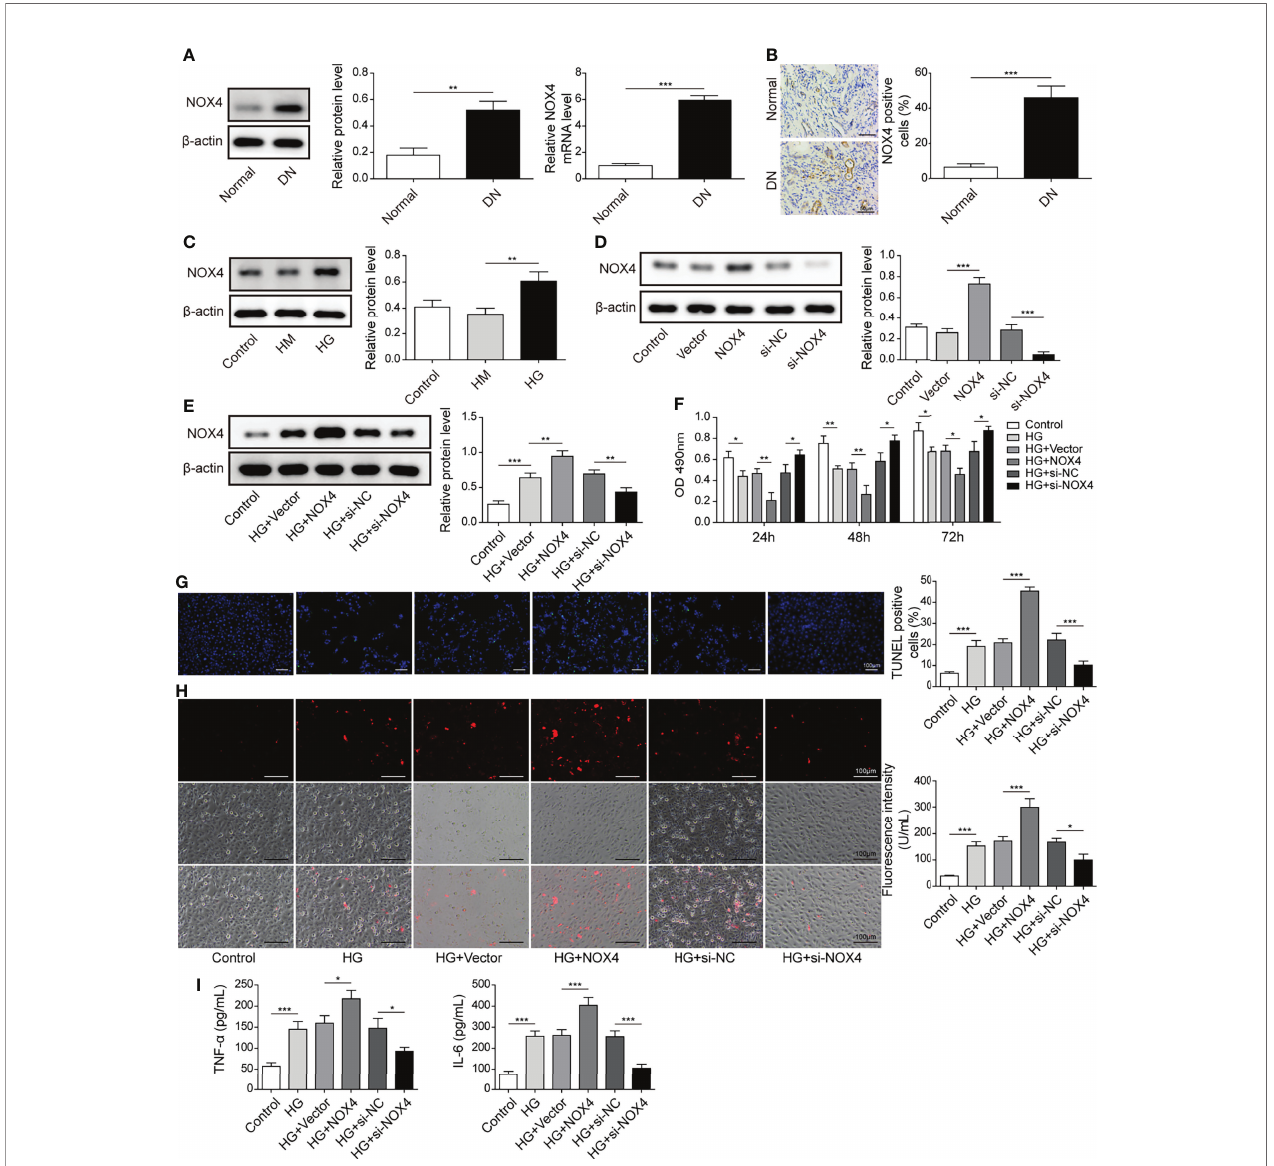
FIGURE 6 | Nox4 exacerbated HG-induced injury in HK-2 cells. (A) The expression of Nox4 in DN and normal tissues was analyzed by qRT-PCR and western blotting (n=6). (B) IHC staining of Nox4 (n=6). (C) Protein levels of Nox4 in HK-2 cells treated with NG, HM or HG were examined by western blotting (n=4). (D) Western blotting analysis of Nox4 in HK-2 cells transfected with vector, oe-Nox4, si-NC or si-Nox4 (n=4). HK-2 cells were transfected with vector, oe-Nox4, si- NC or si-Nox4 and subsequently treated with HG for 48 h (E) Nox4 was detected using western blotting (n=4). (F) Cell viability was examined by MTT assays (n=4). (G) TUNEL staining (TUNEL, green. Scale bar=100 µM) were examined. (H) Cellular ROS levels were examined by a fl uorometric ROS sensor (red, n=4. Scale bar=100 µM). (I) Secretion of TNF- a and IL-6 into culture supernatants (n=4). * P < 0.05, ** P < 0.01 and *** P <